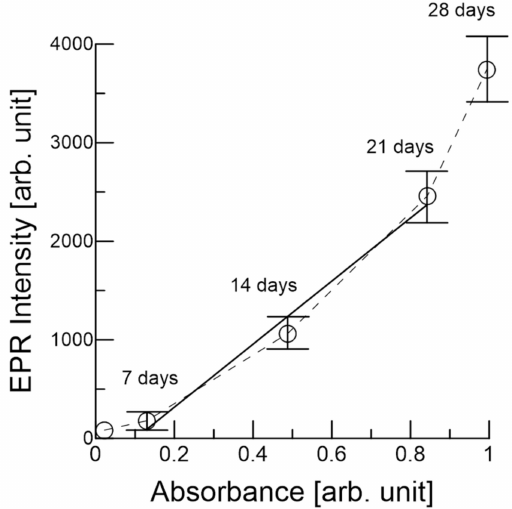
Figure 6. Plot of the normalized EPR intensity versus melanoidin absorption at 400